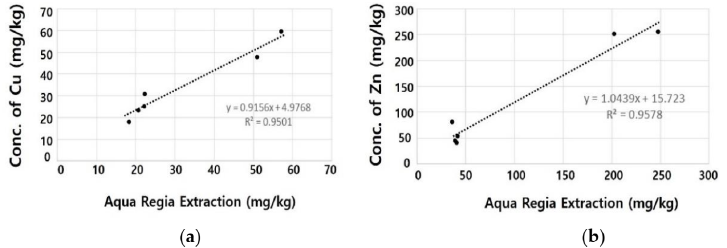
Figure 5. Correlation between aqua regia and sequential extraction for ( a ) Cu and ( b )